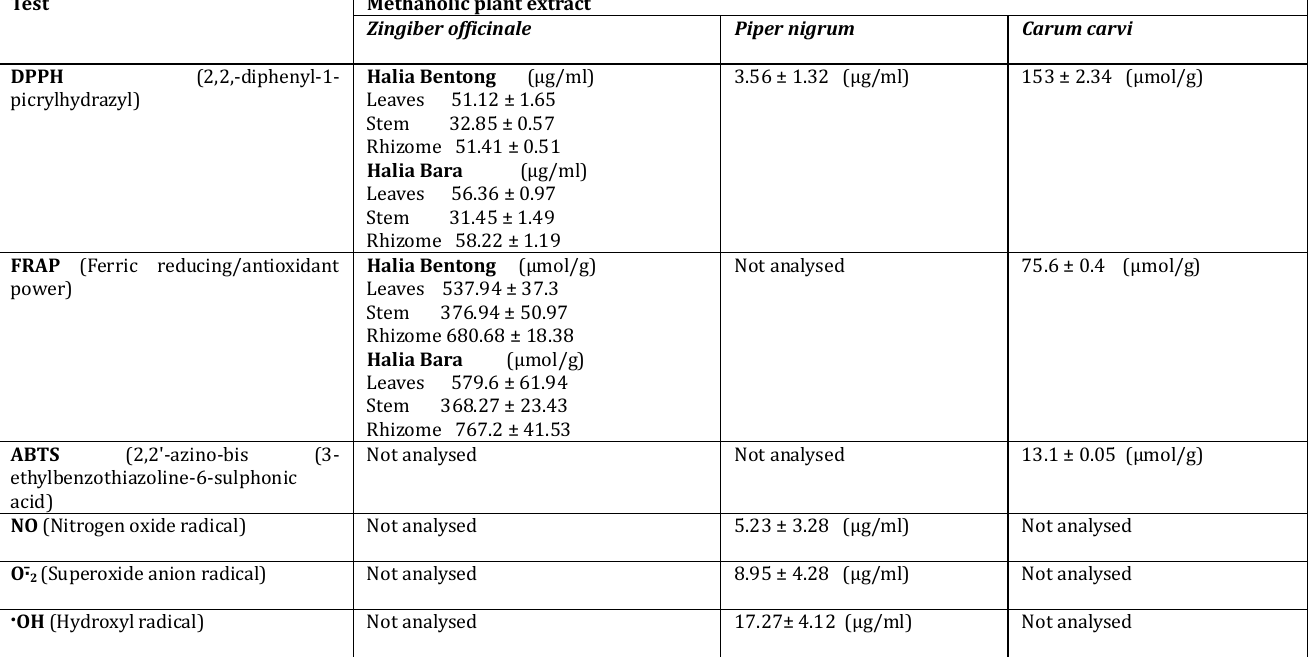
Table 4: In vitro anti-oxidant activity of